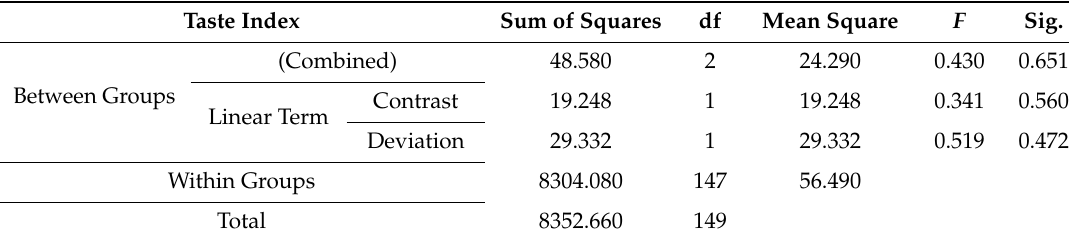
Table 5. ANOVA analysis for property of taste index.